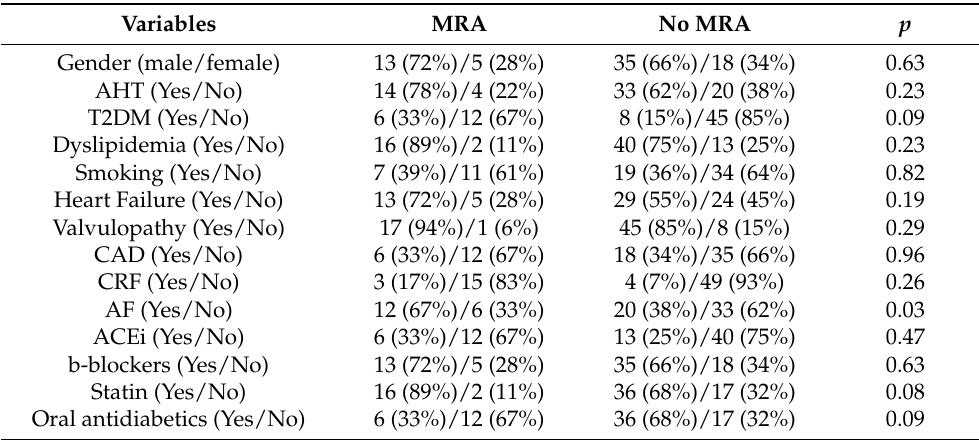
Table 3. Clinical characteristics of patients with /without